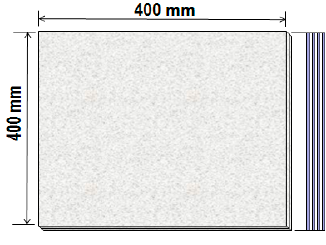
Figure 2. Wavelet analysis of experimental signal for mode verification.